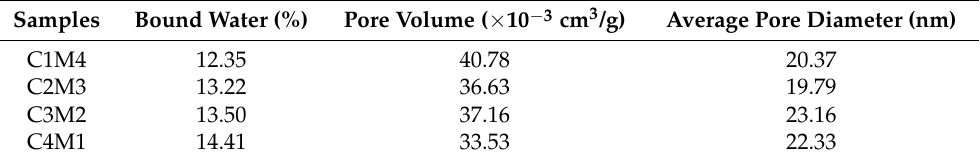
Figure 8. Thermogravimetric curves of the Na 2 CO 3 –activated slag binders modified with Ca(OH) 2 and Mg(OH) 2 . Table 3. Bound water and pore structure parameters of the Na 2 CO 3 -activated slag binders modified with Ca(OH) 2 and Mg(OH) 2 .